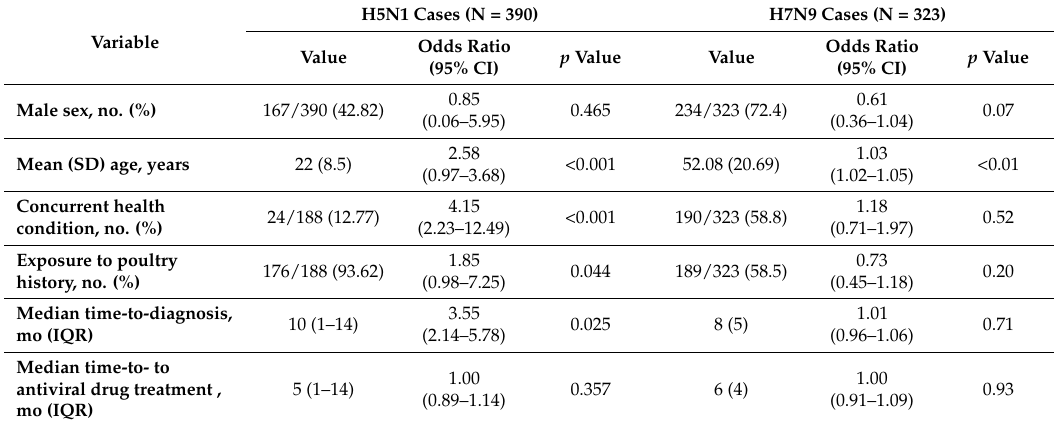
Table 4. Multivariate logistic regression model assessing odds ratios of risk for death for